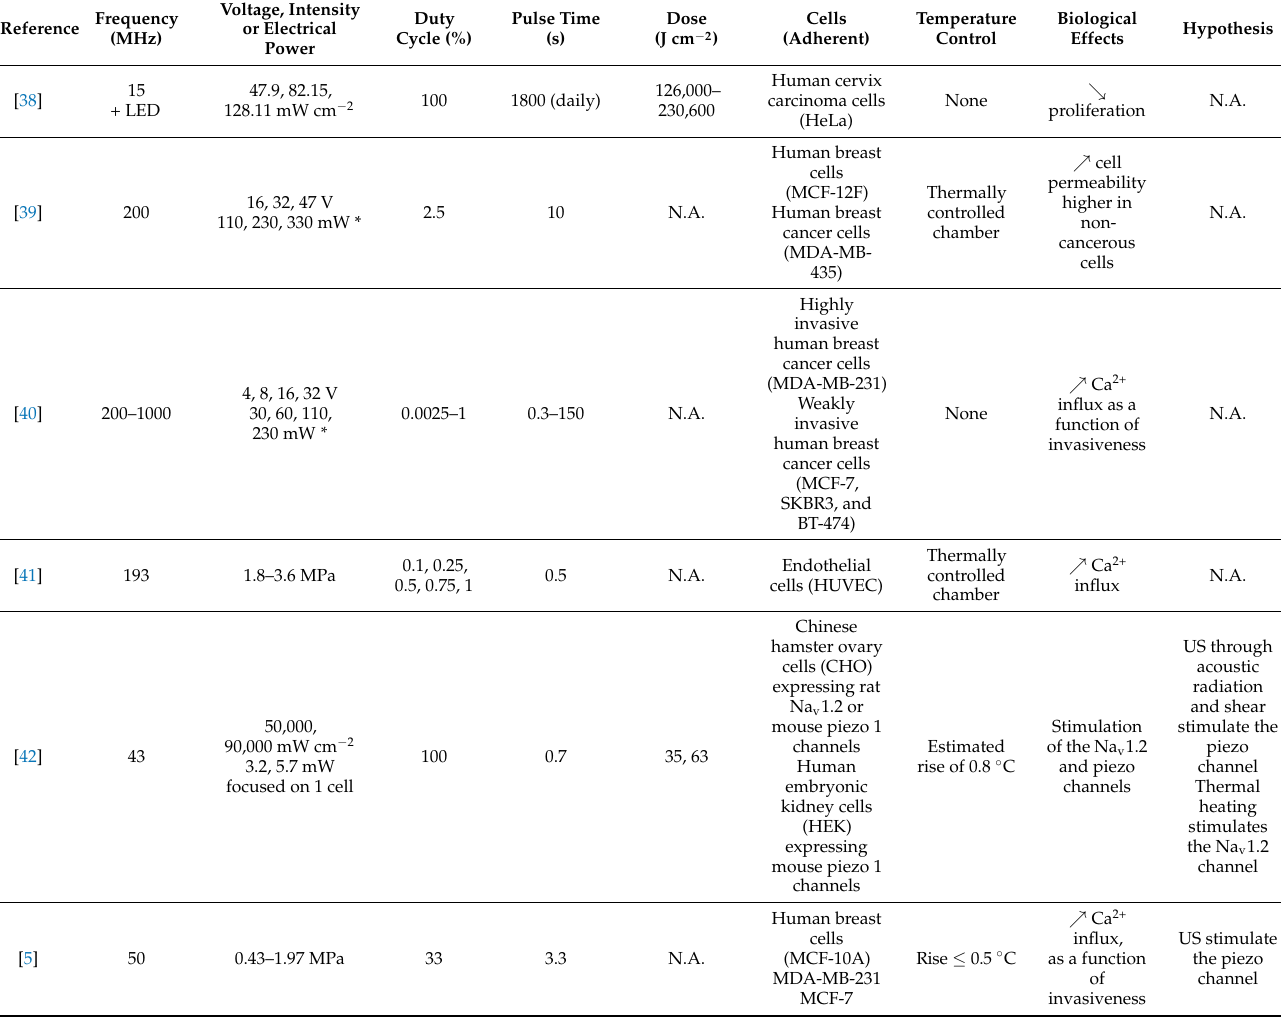
Summary table of the impacts on mammal cells of bulk US at frequencies from 10 to 1000 MHz. ( (cid:37) : increase in, (cid:38) : decrease in, N.A.: not available, *: extrapolation based on the hypothesis that the electrode impedance is at 50 Ω